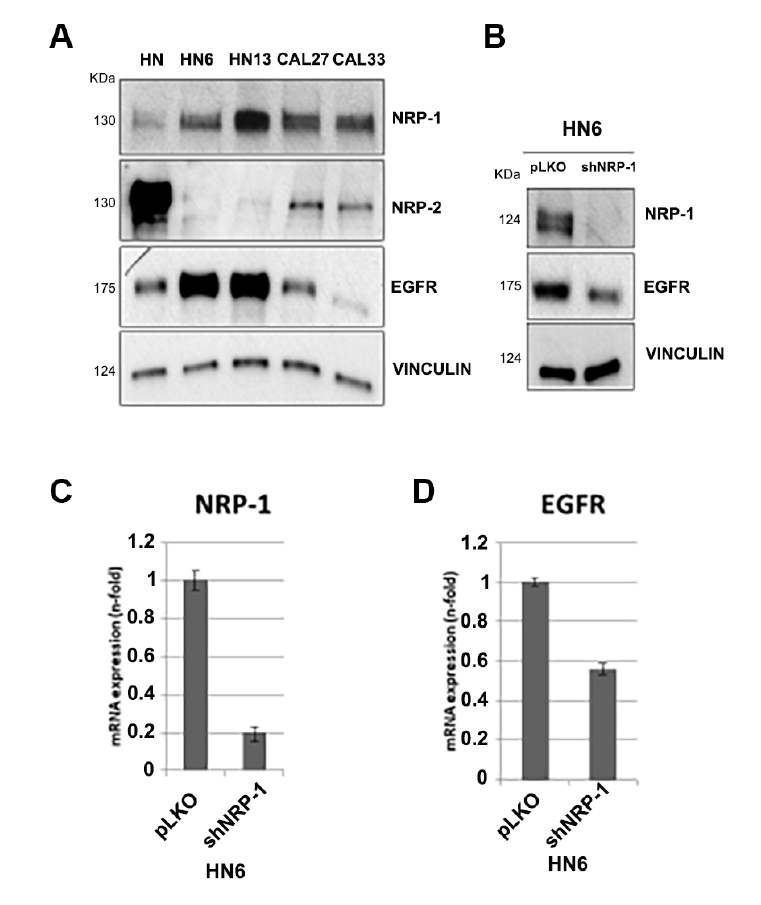
Figure 2. ( A ) NRP-1, NRP-2, and EGFR expression levels in HNSCC cell lines: Western blot (WB) analysis of NRP-1, NRP-2, and EGFR expression detected by specific antibodies, as indicated. ( B ) In HN6 cells, the silencing of NRP-1 affects EGFR activation as detected in the WB. Vinculin in A and B has been utilized as loading control. ( C , D ) NRP-1 and EGFR relative expression was assessed by RealTime-PCR in HN6 cells transfected with pLKO, as control, or with the shNRP-1